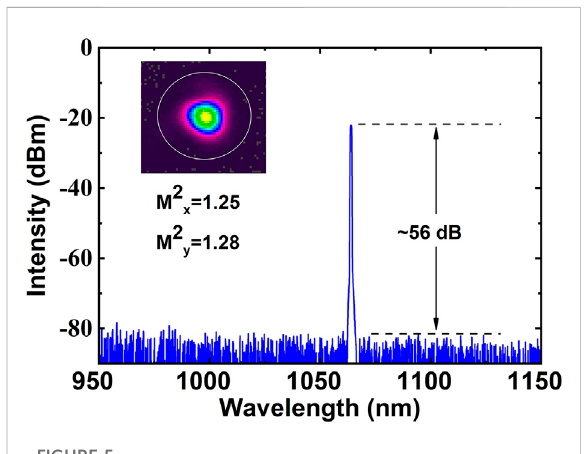
FIGURE 5 Spectrum of the signal laser at the full power of the pre- ampli fi ers (inset: the beam pro fi le and corresponding beam quality M 2 ).